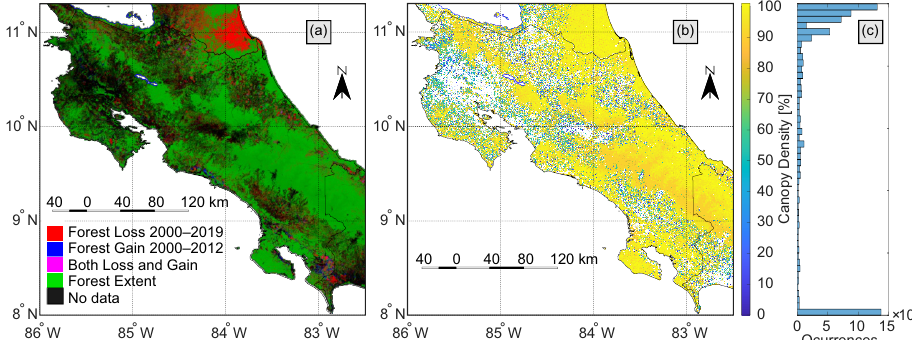
Figure 5. Global Forest Change model. ( a ) Forest cover loss 2000–2019 and forest cover gain 2000–2012 models. Visually, it can be seen that in Costa Rica, no major deforestation events occurred between 2000 and 2019; however, many relatively small areas have both losses and gains in vegetation. Some of them are cropland and changes due to agricultural activity. There was a significant forest loss in the southeast part of Nicaragua, which is part of the study area. ( b ) Tree canopy cover for year 2000. ( c ) Histogram of the tree canopy cover for year 2000 model. The vertical axis is shared between ( b , c